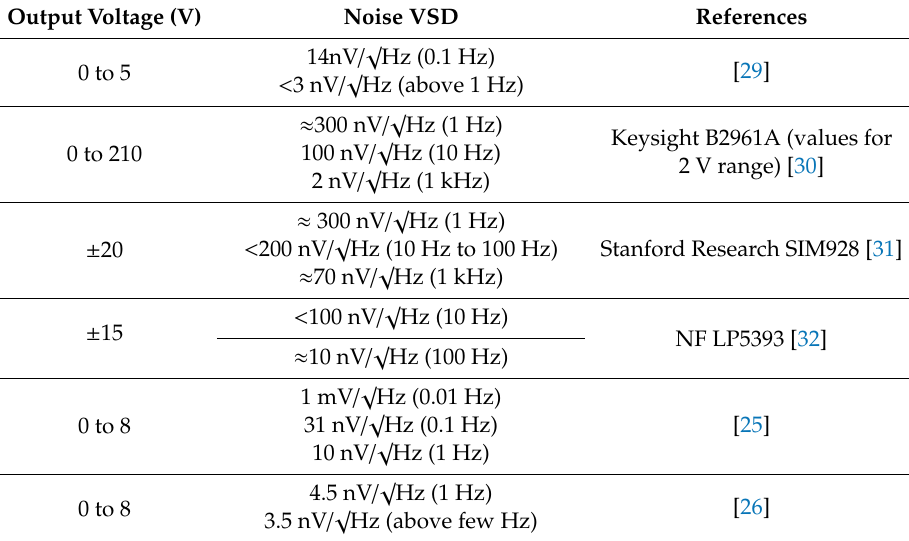
Table 1. Noise performances of some programmable voltage